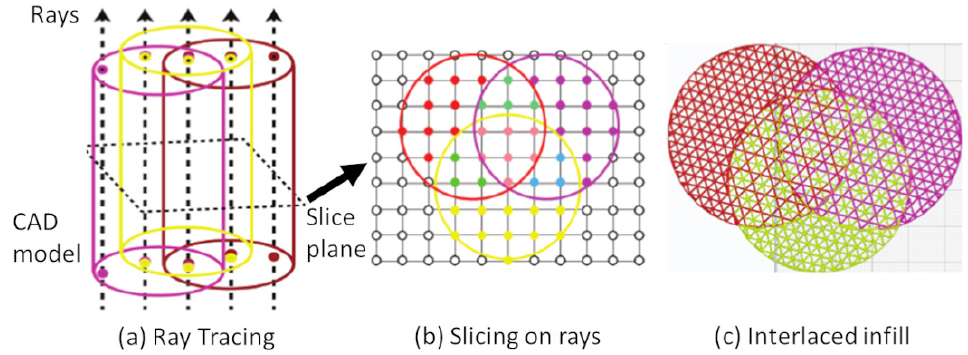
Figure 4. Overview of the present framework. ( a ) Tracing rays to intersect with the CAD model getting a set of material points on the rays. ( b ) Putting a slice plane to intersect with the rays to get a 2D grid with materials. ( c ) Generating interlaced infills within the multi-material